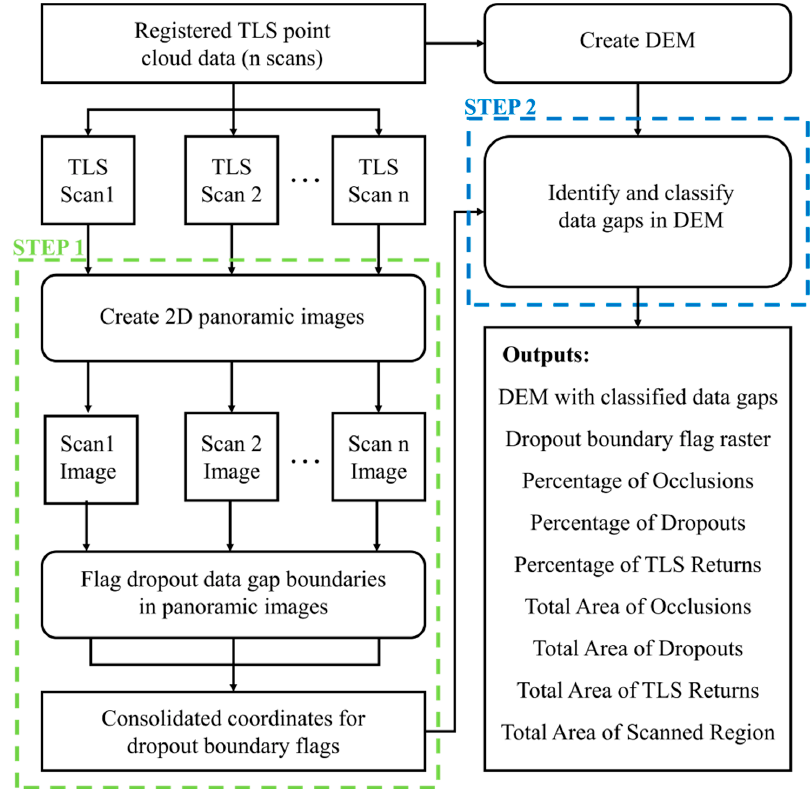
Figure 2. General flow chart for the proposed data gap classification methodology.